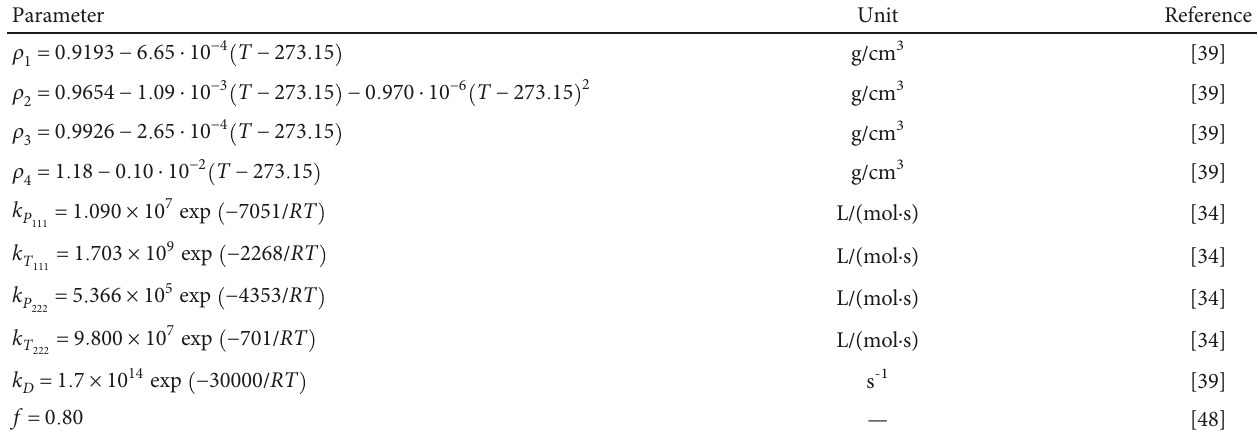
= 1 54 mol, M = 5 00 mol, T = 85 ° C, r 1 2